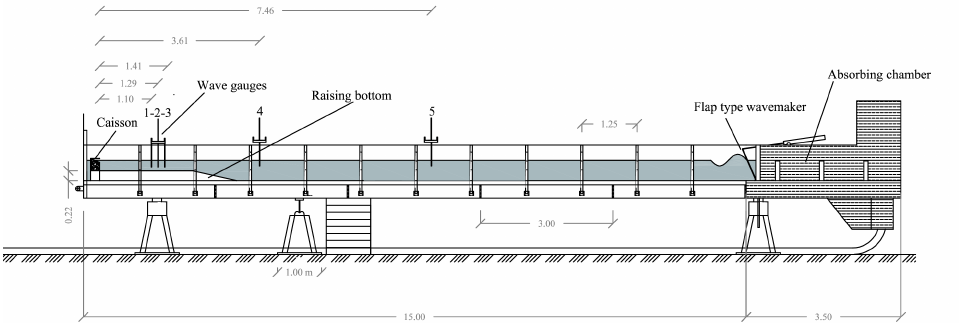
Figure 2. Cross section of the adopted wave flume belonging to Hydraulics Laboratory at the University of Messina (dimension in m).